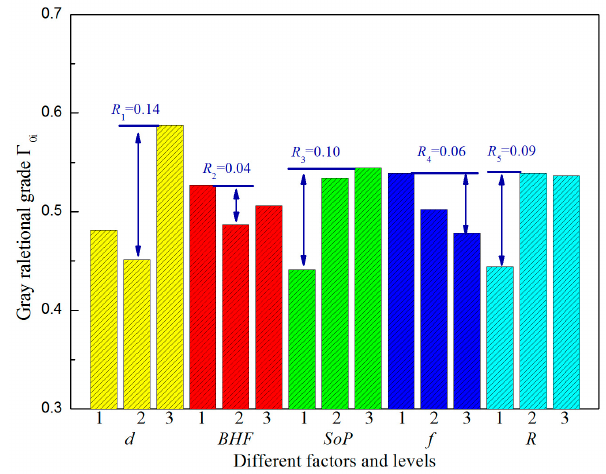
Figure 11. Influence of different factors on the grey relational grade Γ 0 i .